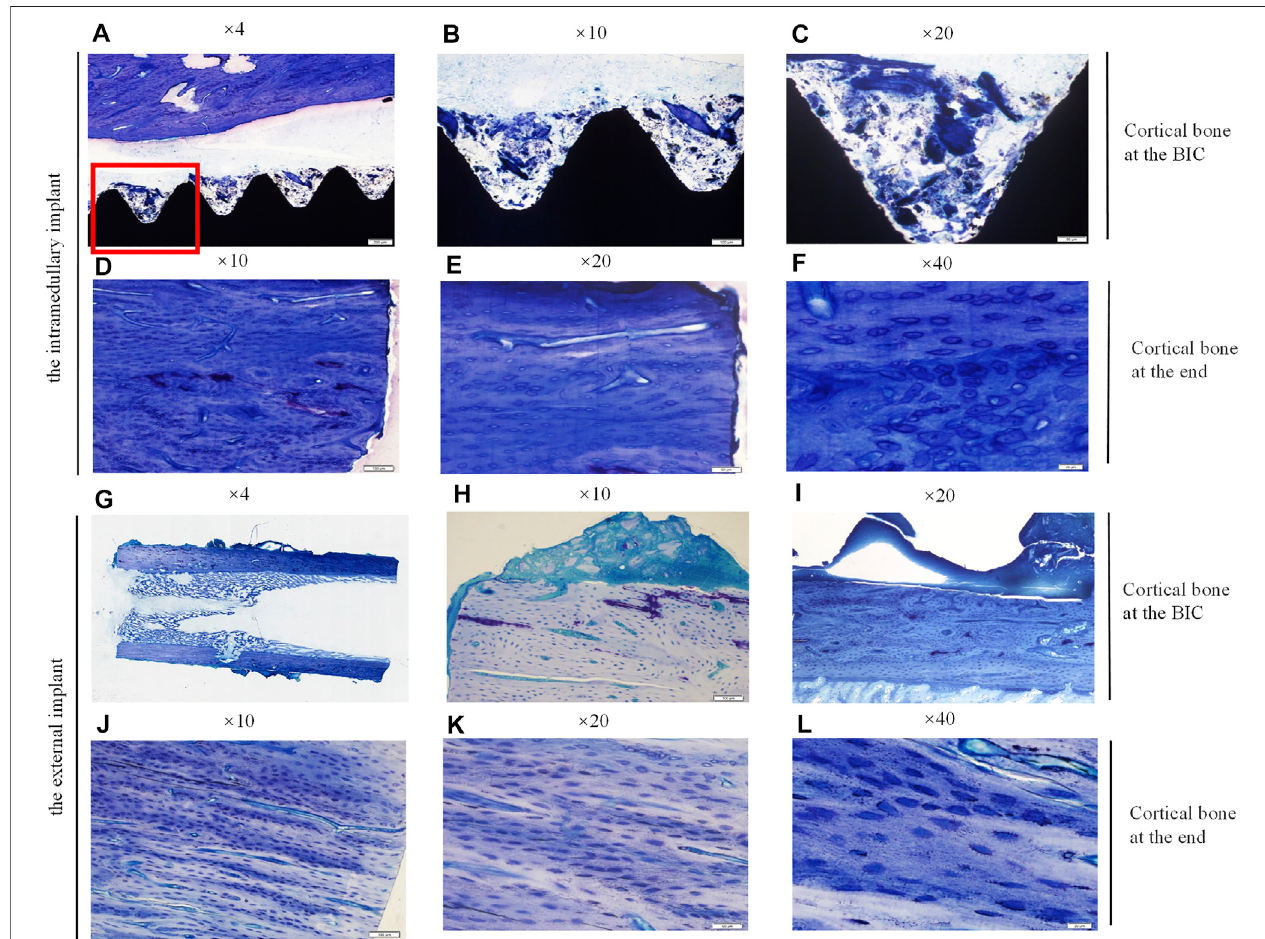
FIGURE 7 | Histological sections and toruidine blue staining of the undecalci fi ed bone samples around the implants, observed using a Histological microscope (magni fi cation ×4, ×10, ×20, ×40). (A – C,G – I) New bone formation within the threads of both implants at the BIC; (D – F,J – L) the cortical bone with more dense osteocytes at the end of the stump. Osteocyte lacunae was